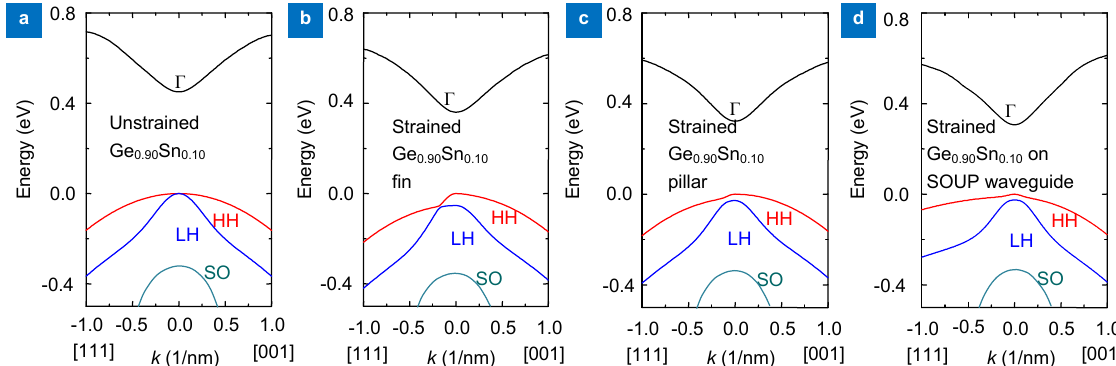
Fig. 2 | E - k energy band diagrams of relaxed and strained GeSn devices . ( a ) Relaxed Ge 0.90 Sn 0.10. ( b ) Tensile strained Ge 0.90 Sn 0.10 in fin array detector with the L pillar of 200 nm. ( c ) Tensile strained Ge 0.90 Sn 0.10 in pillar array detector with the L pillar of 200 nm. ( d ) Tensile strained Ge 0.90 Sn 0.10 on SOUP waveguide. Figure reproduced from: ( a , b , c ) ref. 33 , IEEE; ( d ) ref. 26 , Optical Society of